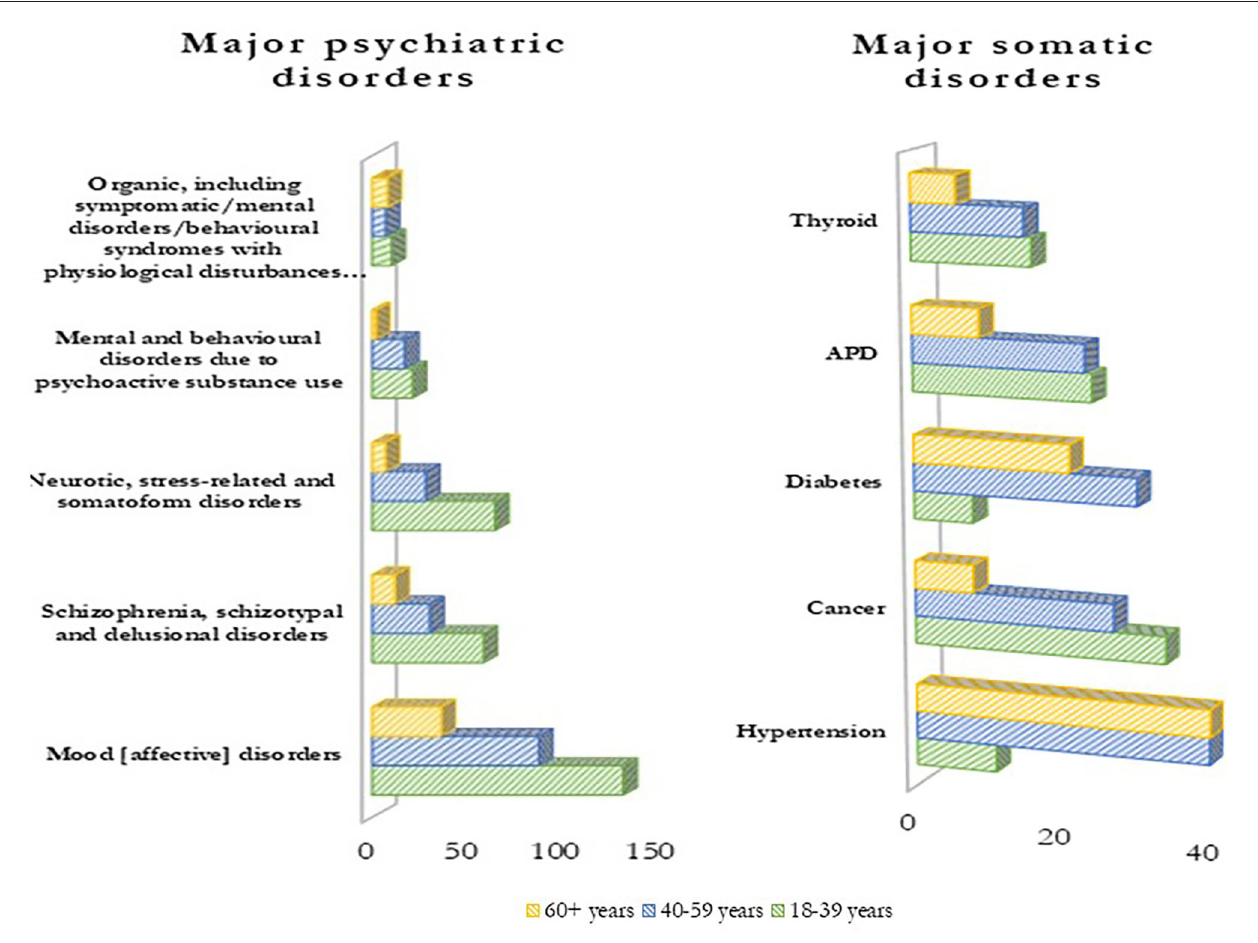
FIGURE 1 | Distribution of major psychiatric and somatic disorders by age